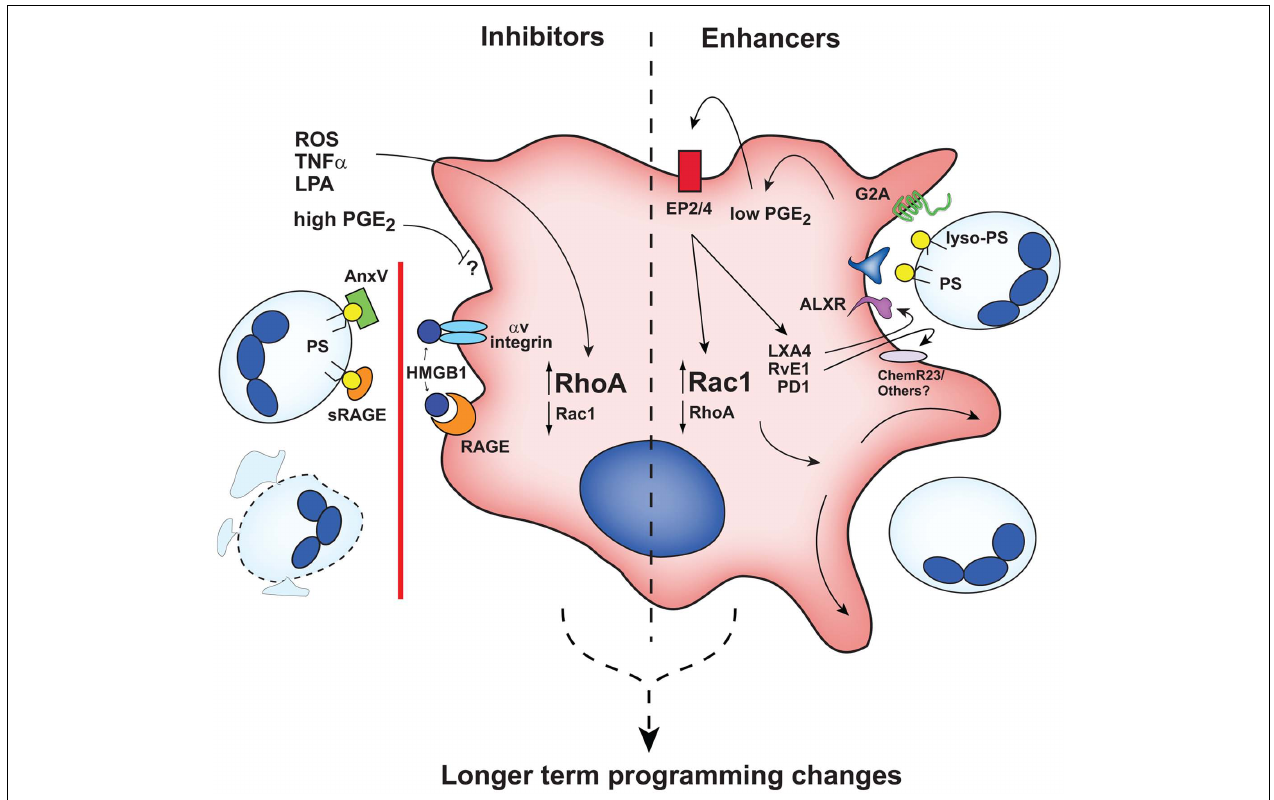
annexin A5; other abbreviations are defined in the text. It is likely that early acting agents also contribute to longer-term macrophage programming as illustrated in Figure 1